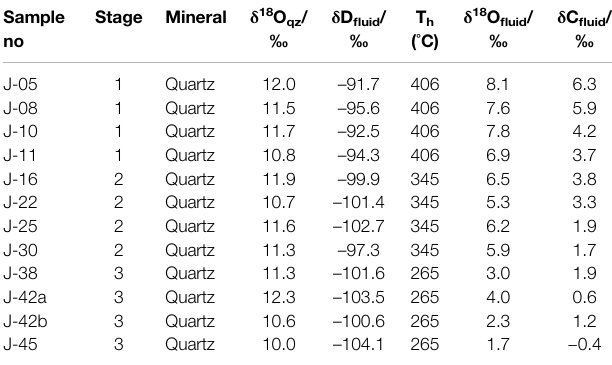
TABLE3| Oxygen,hydrogen,andcarbonisotopedatafromhydrothermalquartz, stages 1 – 3 of the Jinba gold deposit. Sample Stage Mineral δ 18 O qz / ‰ no